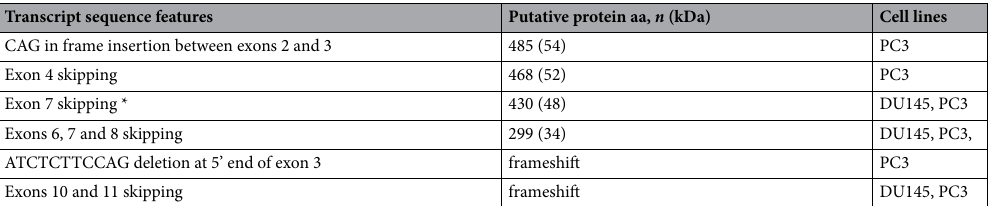
Thus, the cell lines we have analyzed express both the short alternative transcripts reported in NCBI RefSeq database (transcript 5 and X1). However, these two short transcripts do not account for the number of short ETV4 amplicons we have found (Figs. 1c, 2d), suggesting the expression of additional novel ETV4 transcripts. Identification and characterization of these potentially novel alternative ETV4 transcripts have been performed by cloning and sequencing the ETV4 RT-PCR products from PC3 and Du145 cells (primers in exon 3 and 13: Supplementary Table 1). The cloning and sequencing approach confirmed the results obtained with the specific RT-PCR (see above), including the presence of the hypothetical XM_047435592.1 transcript (isoform #X1), and revealed the presence of transcripts 7 and 8 in Du145 but not in PC3 cells (Table 1). Furthermore, this approach revealed also the presence of several additional alternative transcripts (Table 2), few of which having the potential to be transcribed into a protein due to in frame exon skipping: a transcript without exon 4 ( ETV4 ∆4), one without exon 7 ( ETV4 ∆7) and one without exons 6, 7 and 8 ( ETV4 ∆6–8) (Fig. 3a). The presence of these three potentially productive transcripts ( ETV4 ∆4, ETV4 ∆7 and ETV4 ∆6–8) has been tested by specific RT-PCR (Fig. 3b–d). The transcripts ETV4 ∆4, ETV4 ∆7 and ETV4 ∆6–8 should encode for putative ETV4 proteins of 468 aa (52 kDa), 430 aa (48 kDa) and 299 aa (33 kDa), respectively. In addition, ETV4 ∆6–8 should present the substitution of an Cell